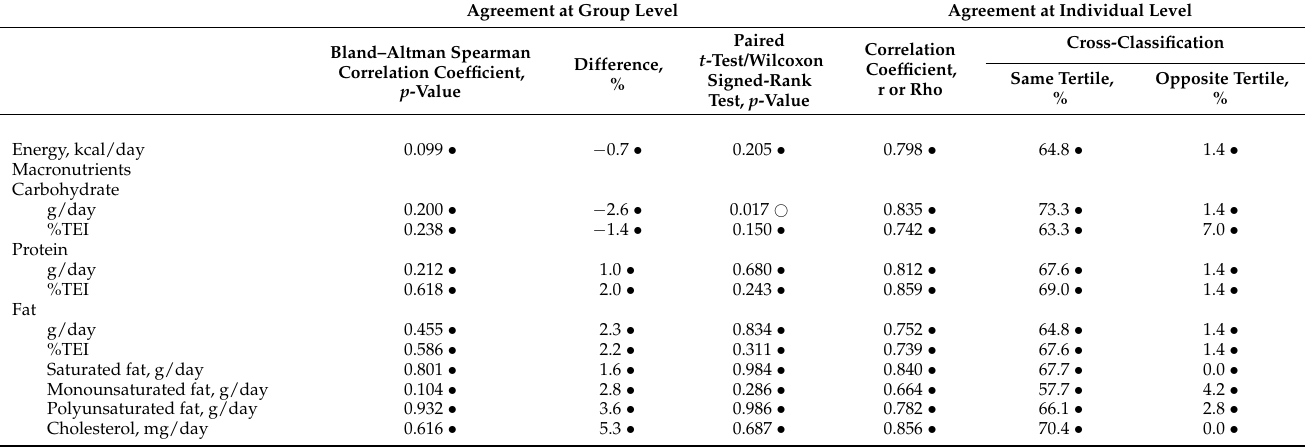
Table 1. Summary of statistical test outcomes and interpretation of energy and nutrient intakes to assess the relative validity of Remind